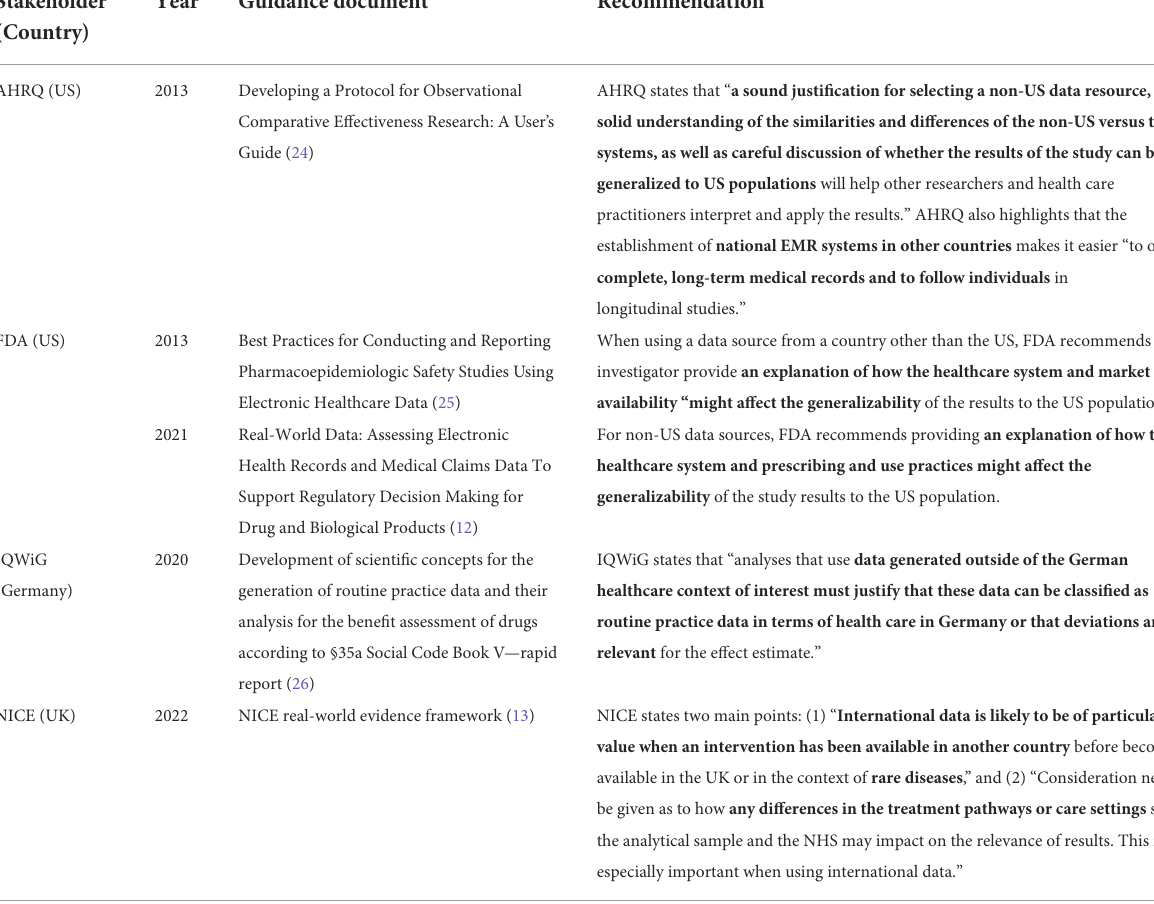
TABLE 1 Recommendations from key stakeholders on the transferability of